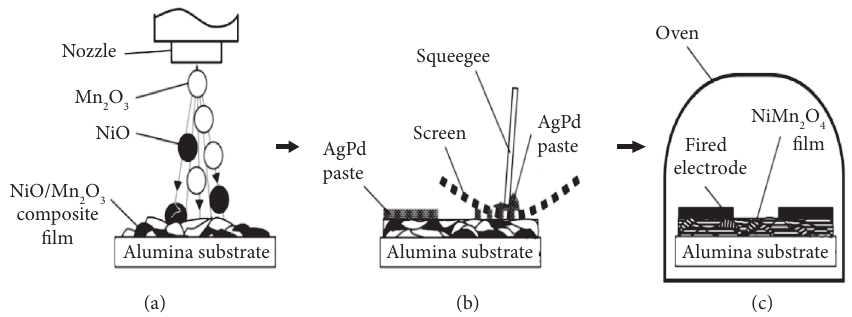
Figure 10: The expert model of building energy intelligent management is applied to the energy management of the building garden.